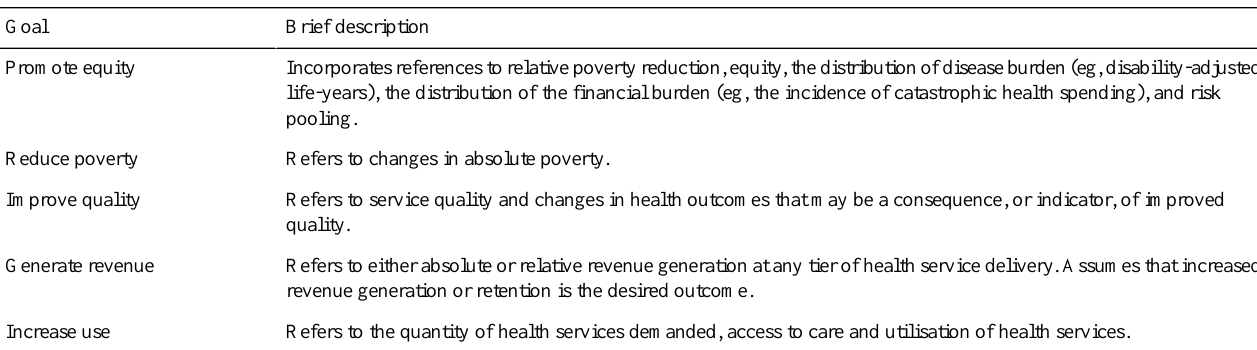
Table 1. Possible goals of a health financing policy.